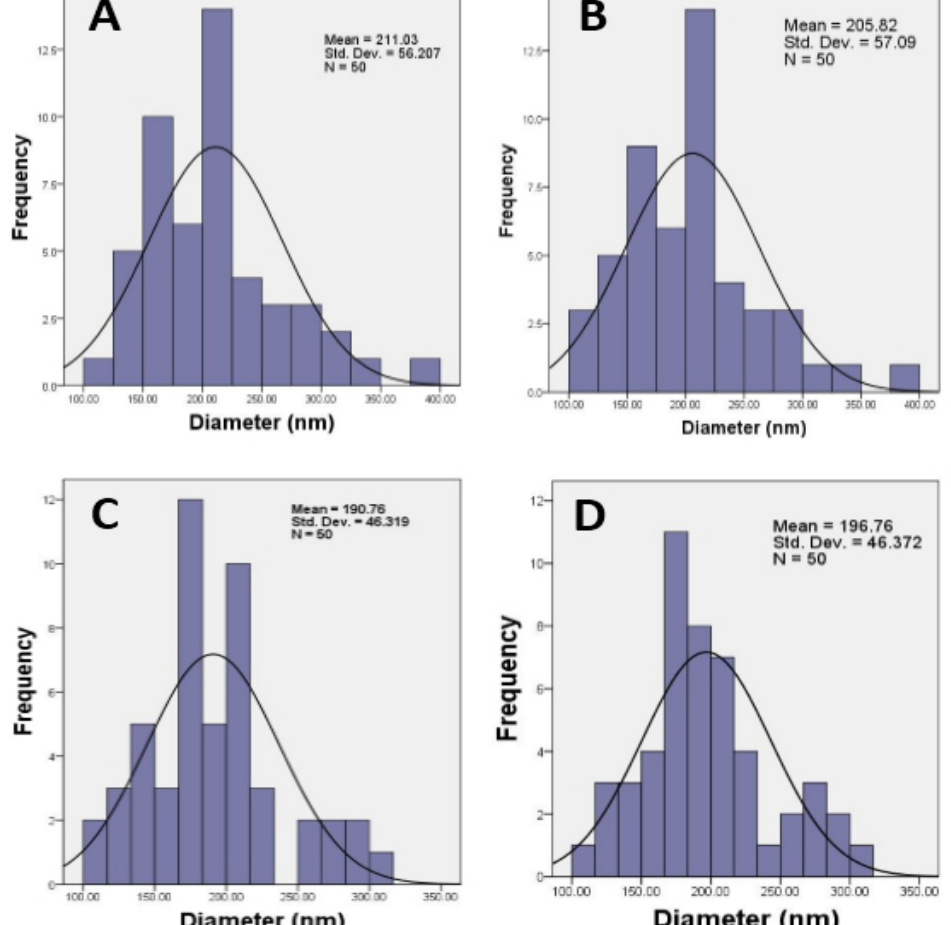
Fig. 2. Diameter distribution of pure PAN nanofibers with loadings (A) 8 wt%, (B) 10 wt%, (C) 12 wt%, and (D) 14